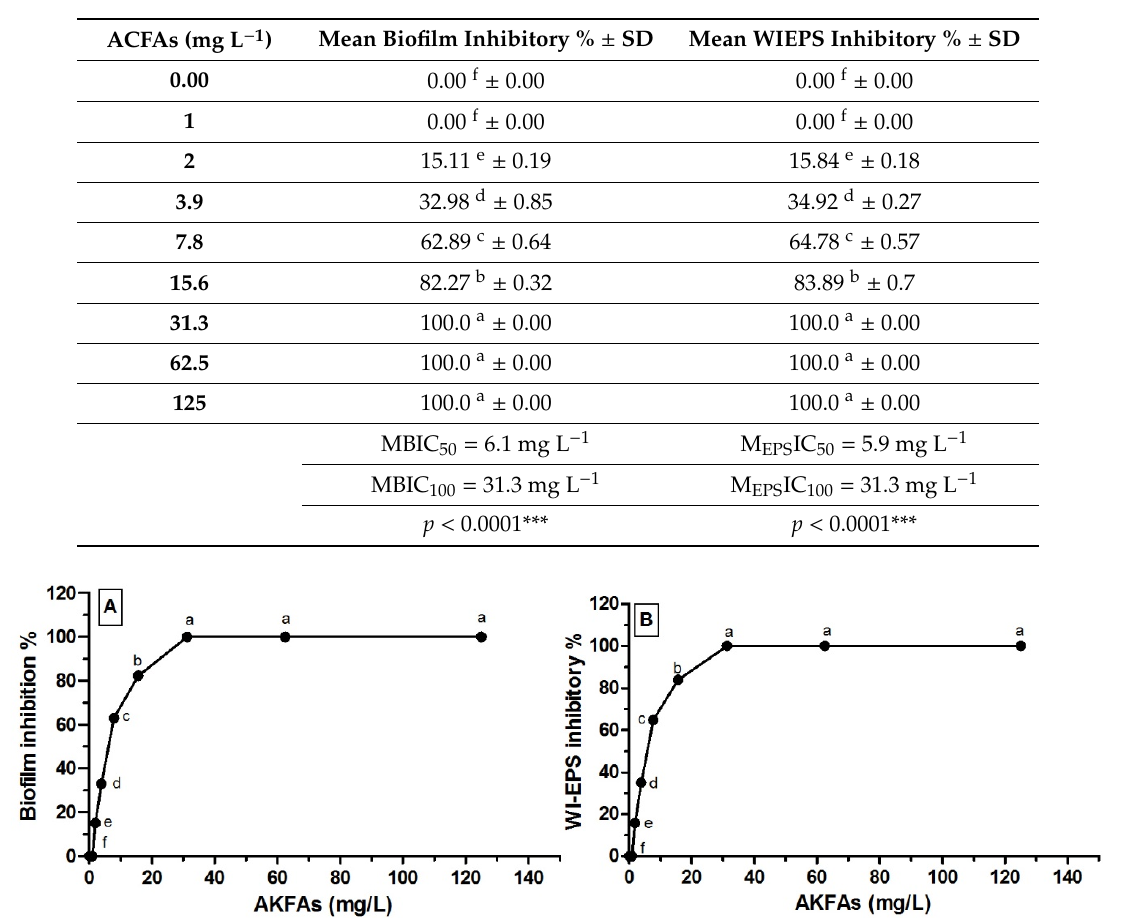
Table 2. Effect of AKFAs on S. mutans biofilm formation and WI-EPS production. ***Significance level p < 0.0001. Tukey’s test: Means sharing the same superscript letter in the same column are not significantly different.